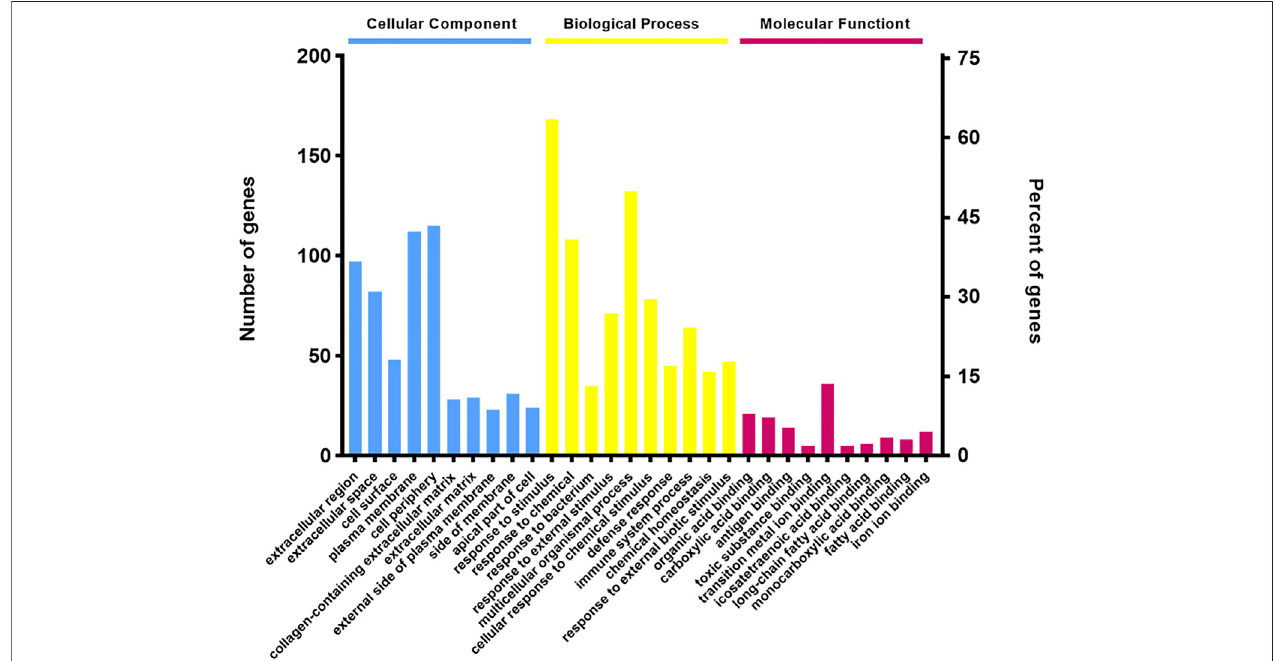
FIGURE4| GeneOntology(GO)termperformanceanalysisofdifferentiallyregulatedproteinsbetweentheBLM+TLgroupandBLMgroup.AnoverviewoftheGO annotationsoftop10signi fi cantlyenrichedtermsinthreecategories:cellularcompartments,biologicalprocesses,andmolecularfunctions( p < 0.05).Termsinthesame category wereordered based on the p -values, increased from left toright. Information forthe numbers ofinvolved genes/proteins and percentages in aterm is provided on the left and right vertical axes.